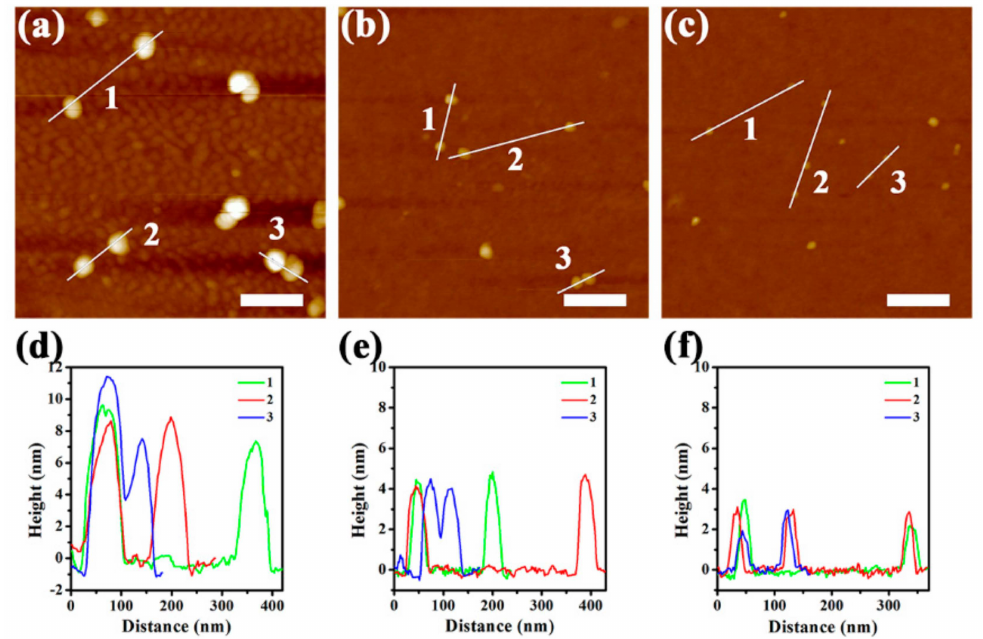
Figure 2. ( a – c ) AFM images and ( d – f ) corresponding height profiles of WSe 2 NSs with different